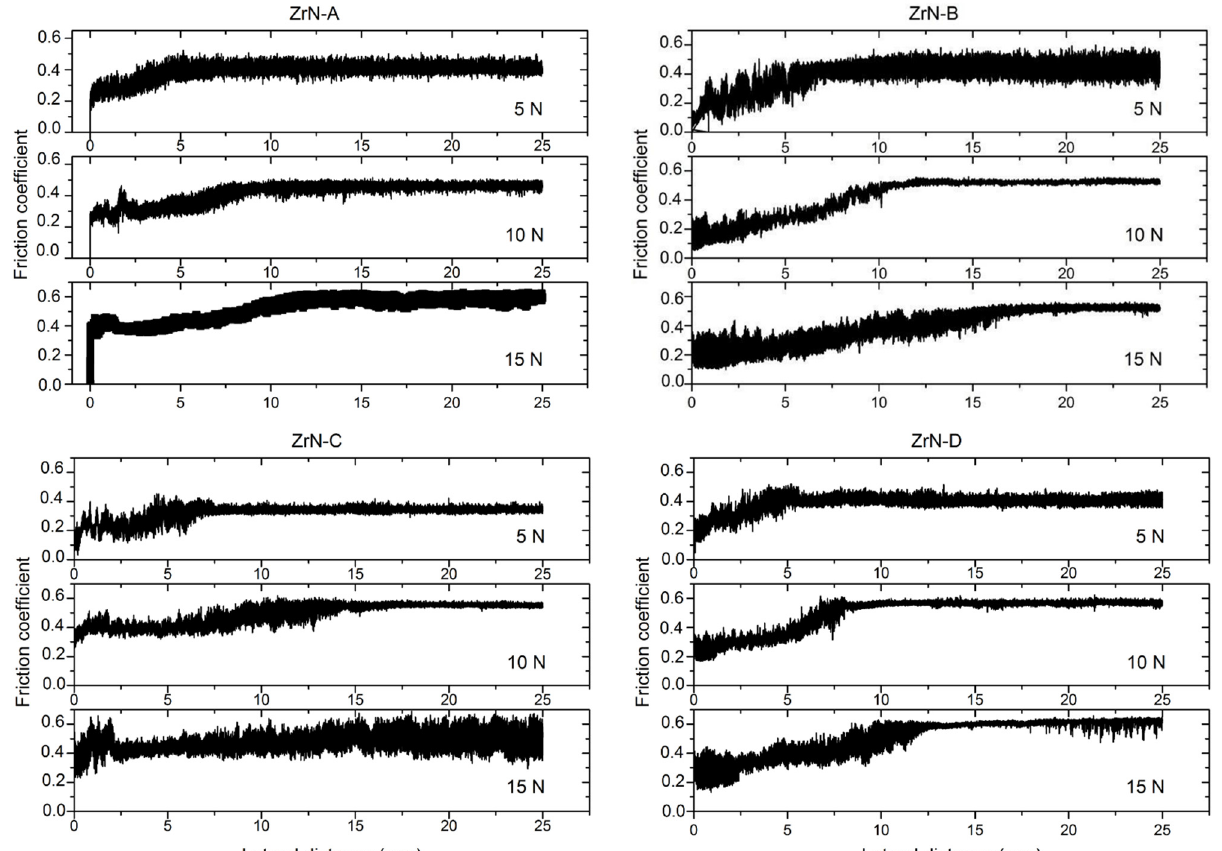
Figure 3. Friction coefficient measurements at loads of 5, 10, and 15 N.